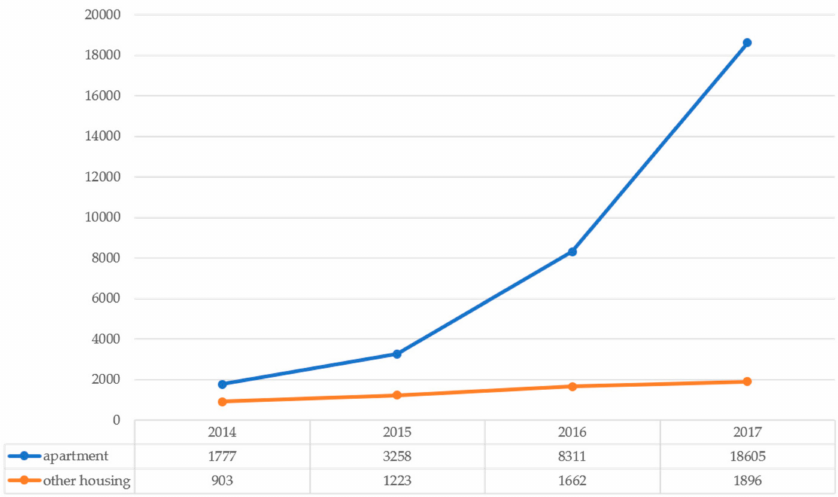
Figure 3. Number of households with solar PVs by housing type in